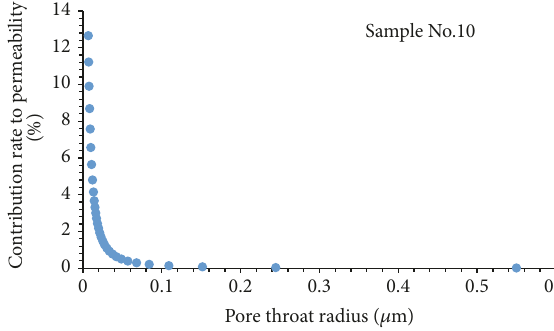
Figure 6: Pore throat radius and its contribution rate to permeabil-